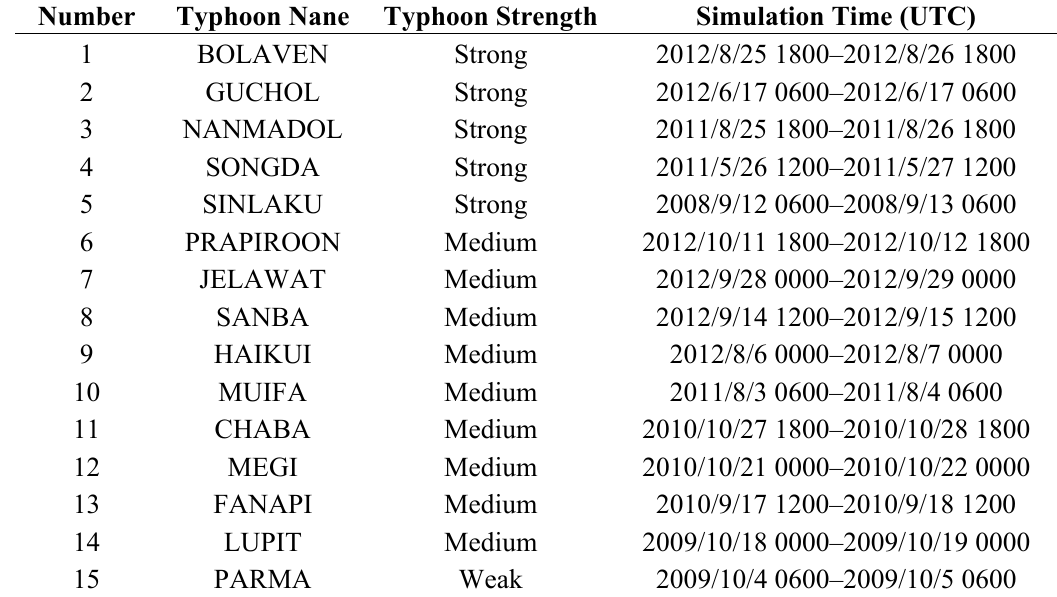
Table 2. Fifteen typhoons considered for constructing the conditional probability density